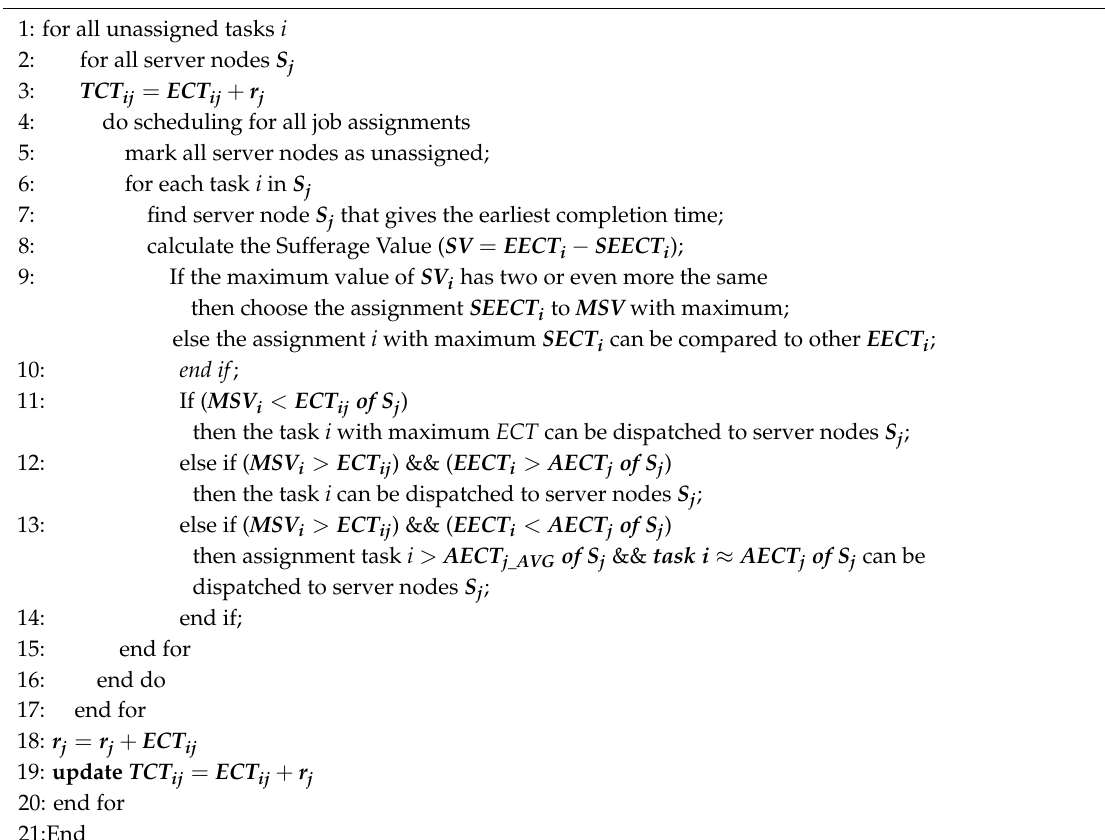
Algorithm 2. Advanced Cluster Sufferage